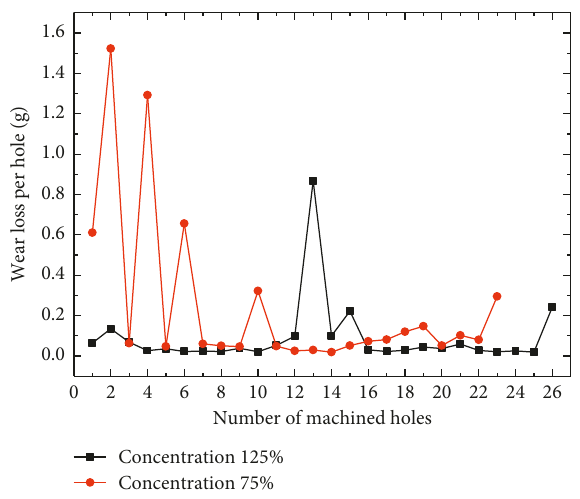
Figure 5: Wear rates of the bit under different diamond